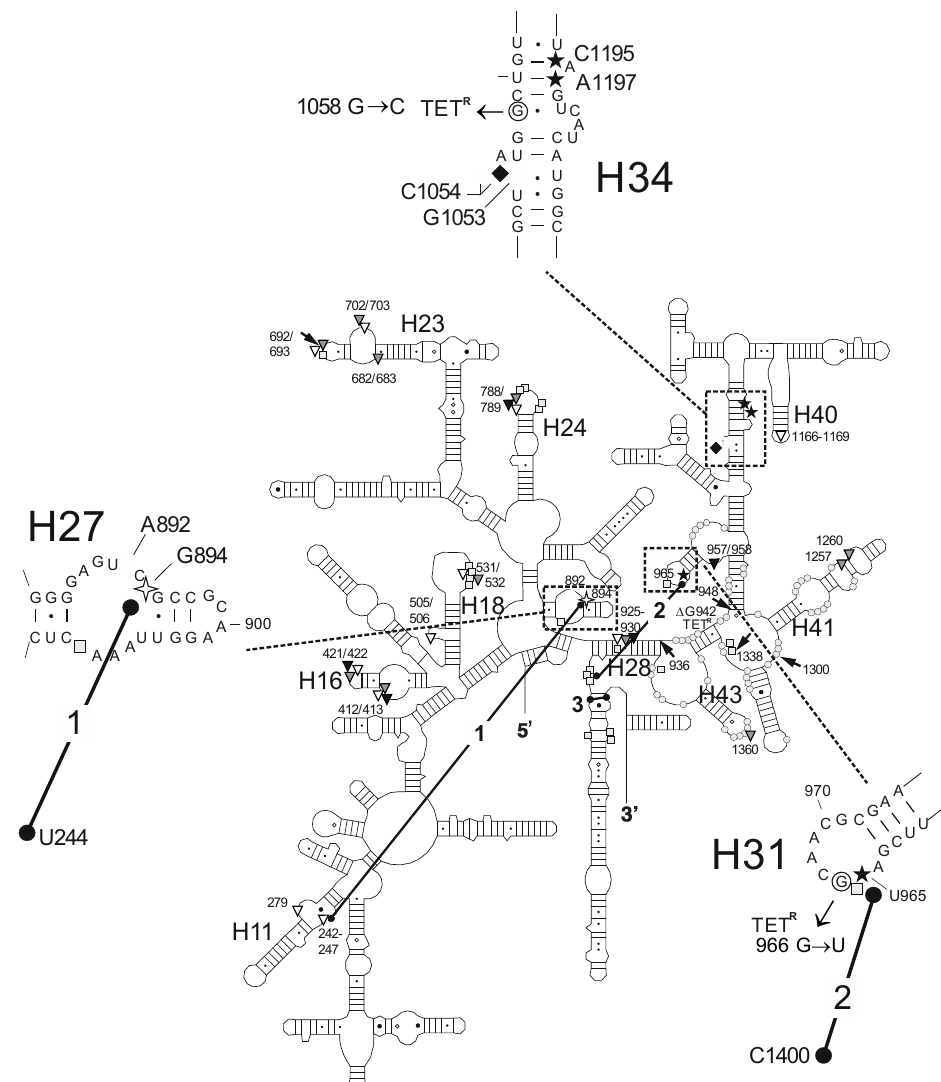
Figure 4. Summary of the interaction sites of TET, TGC, and OMC with the 16S rRNA. The secondary structure of the E. coli 16S rRNA is shown schematically [44]. Located within the stippled boxes and shown in more detail in the enlarged sections are bases that (i) display altered reactivity towards DMS probing in the presence of TET, TGC or OMC (white diamond: TET only; black diamond: all three) [15,25]; (ii) lead to weak resistance against TET, TGC, and OMC when mutated (TET R ) [15,20,21,37]; show either (iii) Fe 2+ ‐ mediated specific cleavage (white 4 ‐ pointed star, black star) [15], or (iv) protection from Fe 2+ ‐ mediated cleavage in the presence of TET, TGC, and OMC (white 5 ‐ pointed star). In addition, the secondary structure contains (i) sites with altered reactivity towards DMS in the presence of tRNA (grey rectangle) [34] or the S7 protein (grey circle) [36]; (ii) direct photocrosslinks to TET (black arrow) [33,45]; (iii) RNA ‐ RNA crosslinks affected by TET (black dumbbell) [35] or (iv) sites with Fe 2+ ‐ mediated non ‐ specific cleavage in the presence of TET (white triangle), TGC (grey triangle) or OMC (black triangle).